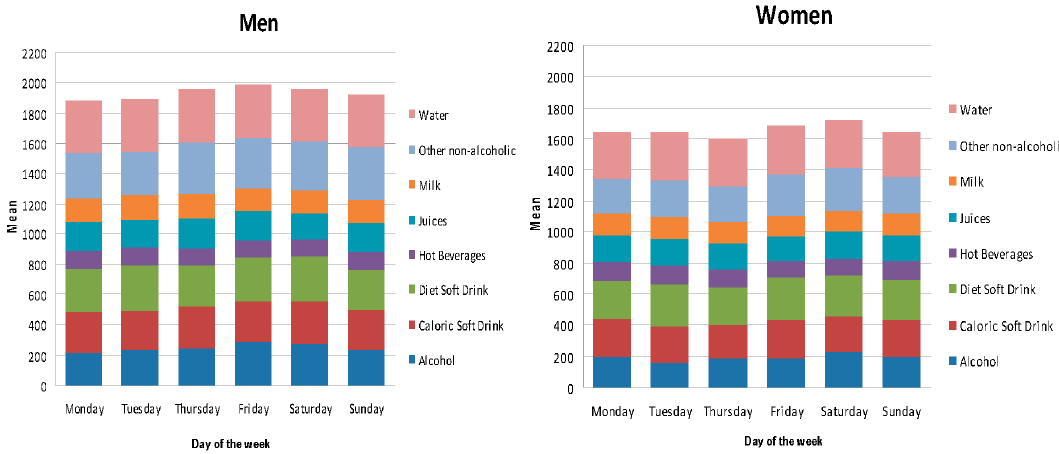
Figure 4. Amount and types of beverages consumed according to day of the week (mean g/day), separated by gender.